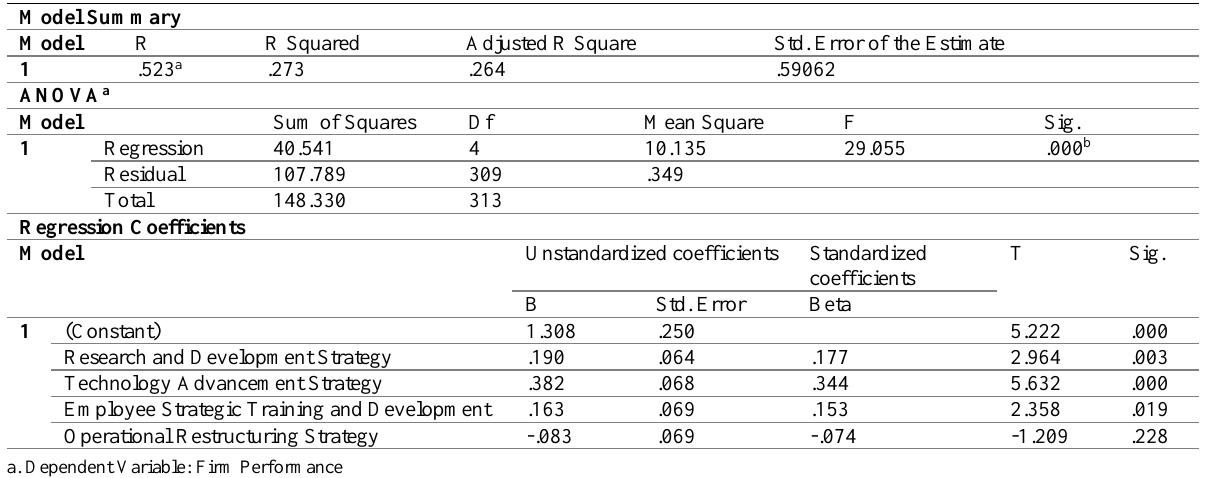
Table 2: Strategic Responses and Firm